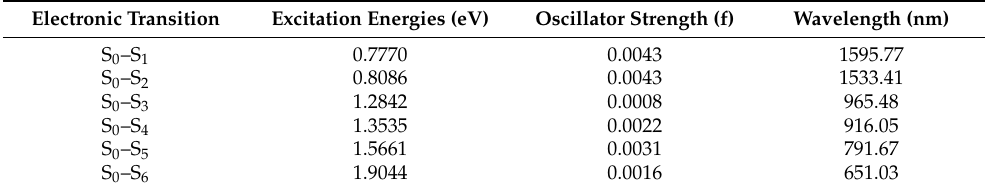
Table 3. Excited states parameters of PbS/Er-3MR local structural model (b).